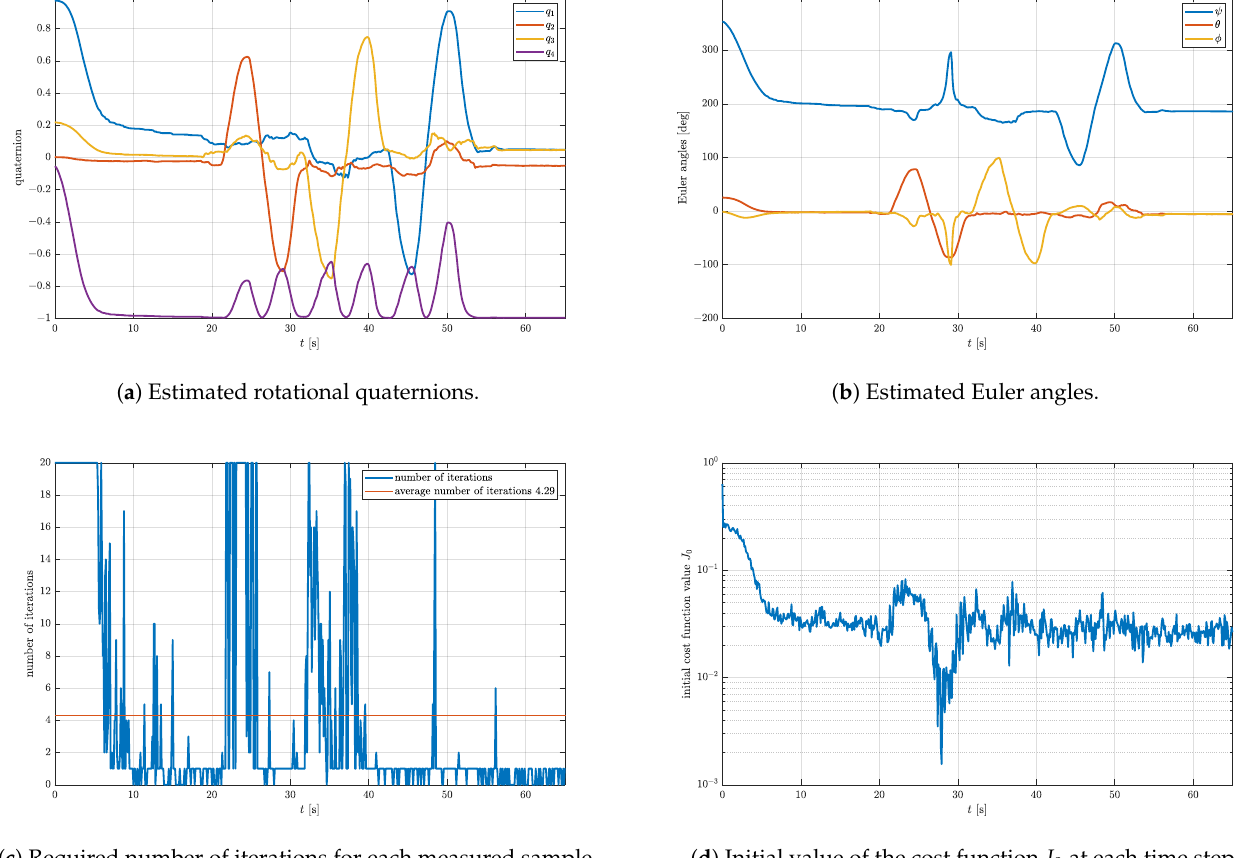
(cid:104) (cid:105) T , N max = 20, 1 0 0 0